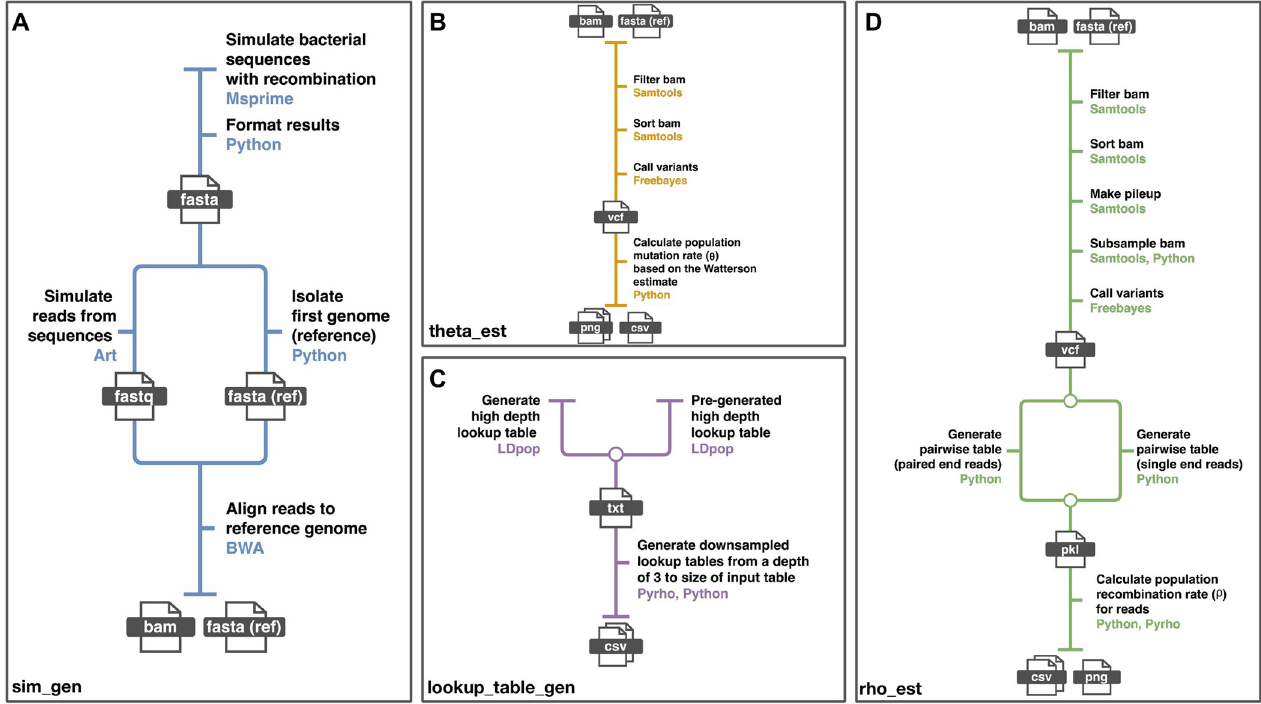
Fig 1. The pipelines that together make up Rhometa. ( A ) Pipeline for generating simulated metagenomic read datasets. ( B ) Pipeline for estimating the population mutation rate ( C ) Pipeline for generating the lookup tables required for the recombination rate estimator ( D ) Pipeline for estimating the population recombination